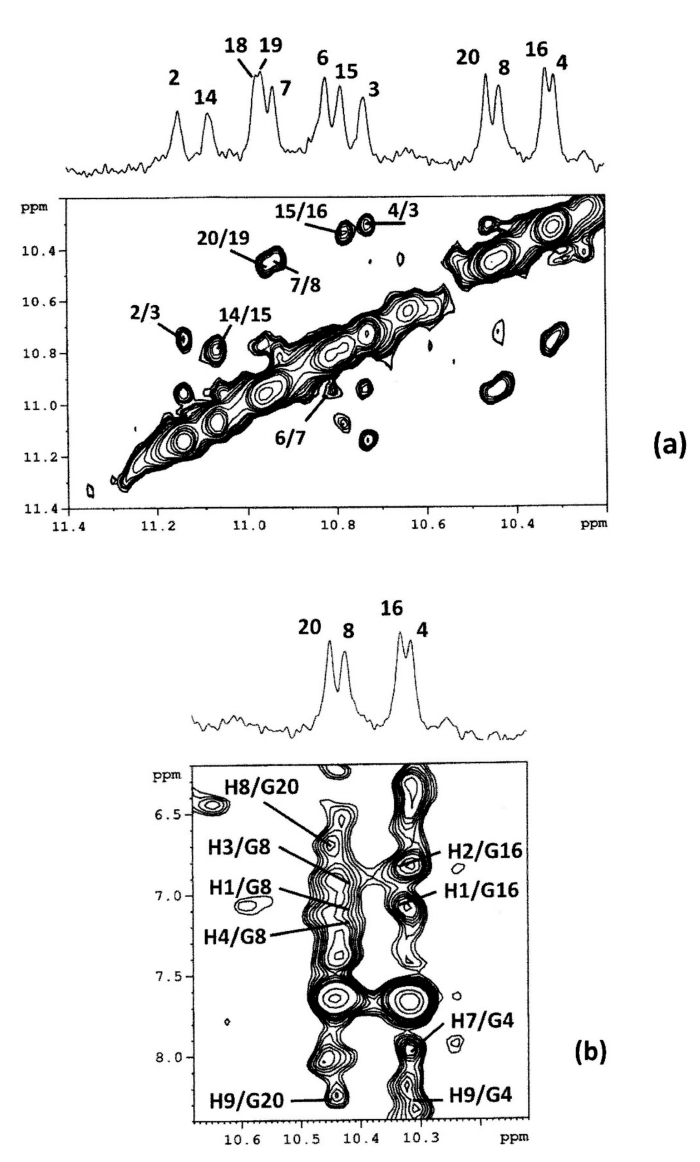
Figure 7. Selected region of the 2D NOESY spectrum of the c-kit212T12T21 / ( 2 ) complex. ( a ) Sequential NOE interactions in the H1 region and ( b ) the intermolecular NOEs between H1 imino protons and ( 2 ) H aromatic